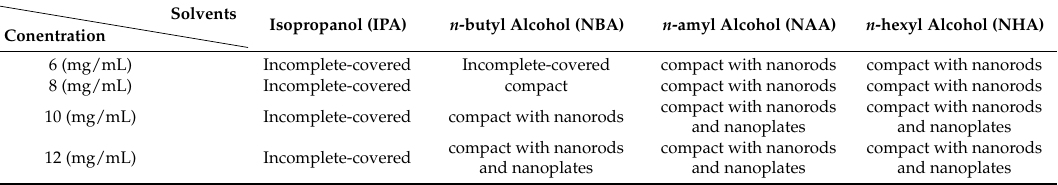
Table 1. Morphologies of CH 3 NH 3 PbI 3 (MAPbI 3 ) films obtained from 6–12 mg/mL CH 3 NH 3 I (MAI) in four-selected